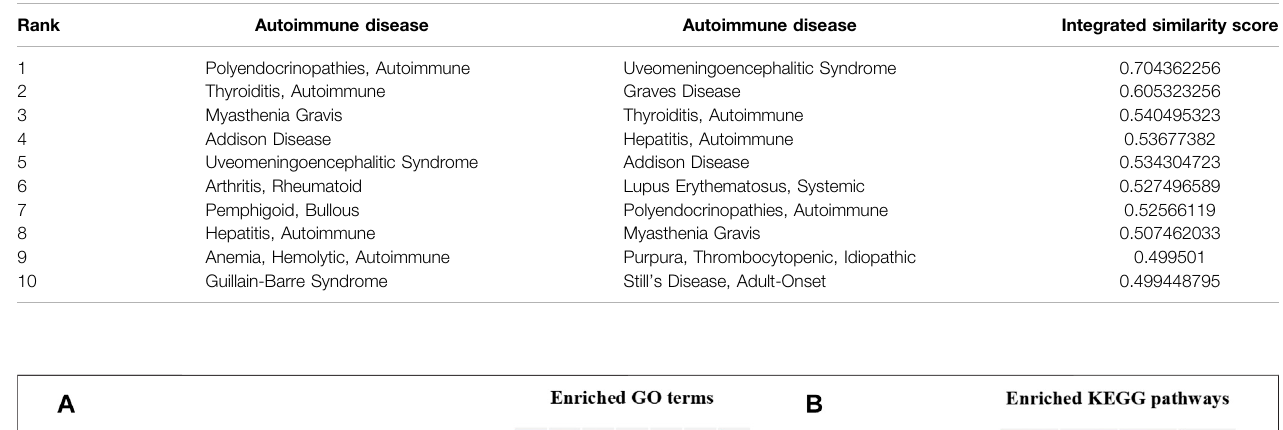
TABLE 2 | Top ten pairs of ADs ranked by integrated similarity scores.